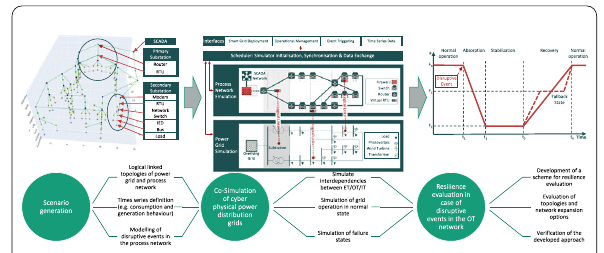
Fig. 1 Overview of the methodological approach for resilience evaluation of cyber‑physical power distribution grids based on a co‑ simulation environment (based on [12,